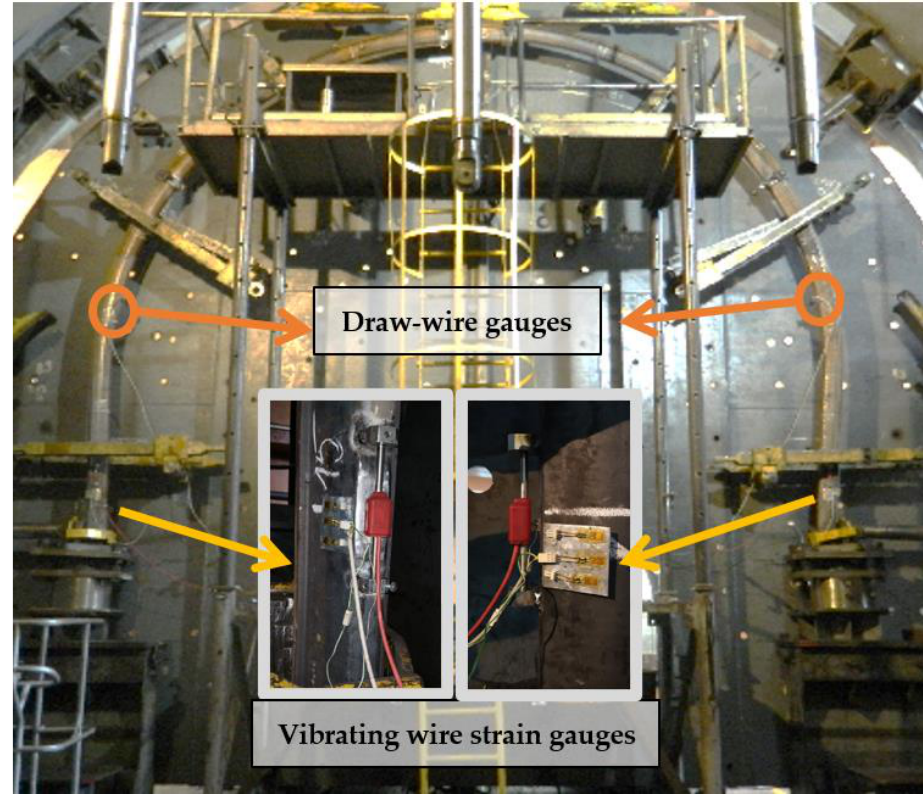
Figure 13. View of the testing facility.